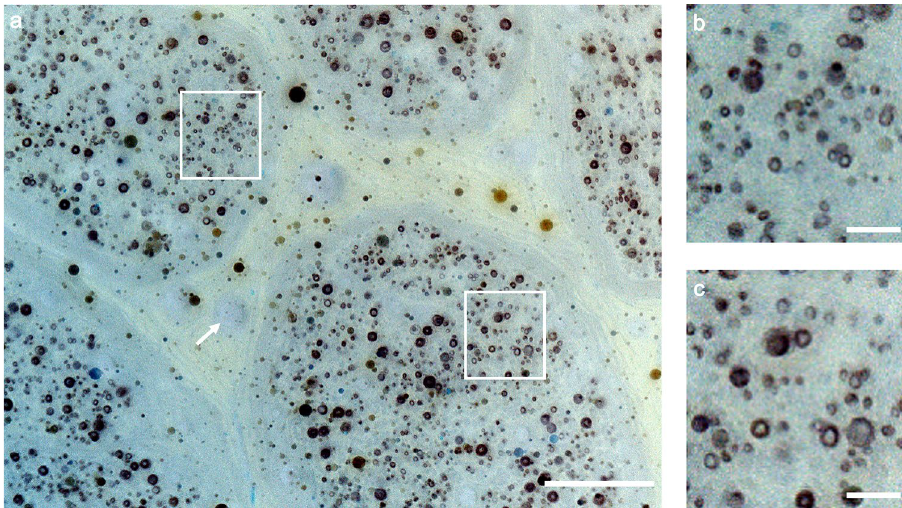
Figure 3. 2D-MUSE image of a cadaver tibial nerve sample, stained with a myelin-specific fluorescent compound (Case Imaging Compound 30 ). Images were color and intensity inverted to improve visual saliency. ( a ) MUSE image, color and intensity inverted to improve visual saliency. ( b , c ) Close up views of regions highlighted by white boxes in ( a ) displaying dark rings, indicative of myelinated fibers. Note the low image contrast from vasculature with this stain (arrow in a ). Scale bars are 100 µm in ( a ) and 50 µm in ( b and c